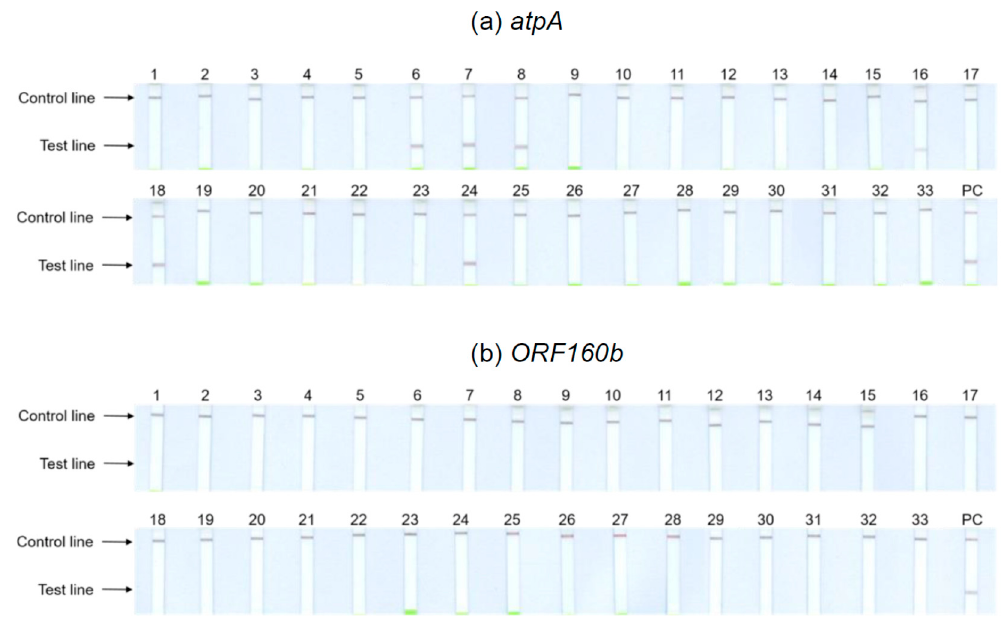
Figure 4. Specificity of ( a ) the atpA and ( b ) the ORF160b LAMP-LFD assays for the detection of allergenic soybean. Cross-reactivity testing with undiluted DNA. Numbers according to Table 1 (PC: positive control tofu).